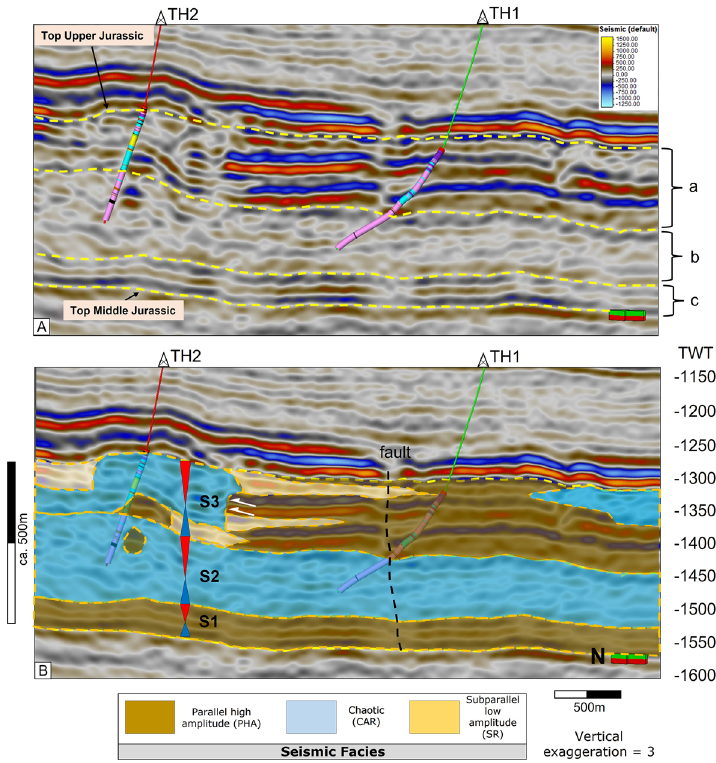
Fig. 9 Seismic line showing the uninterpreted ( A) and interpreted ( B) section. The wells Th2 and TH1 confirm the Top Upper Jurassic and the Upper Malm unit ( a) , as well as part of the Middle Malm unit ( b) . Lower Malm unit ( c) and Top Middle Jurassic cannot be confirmed by the two wells. The interpretation is, however, supported by offset wells and other geothermal projects in the Munich area. Seismic facies analysis and reflector terminations show basin, reef/bioherm, and reef/bioherm debris as well as three large-scale depositional sequences (S1–S3) and a